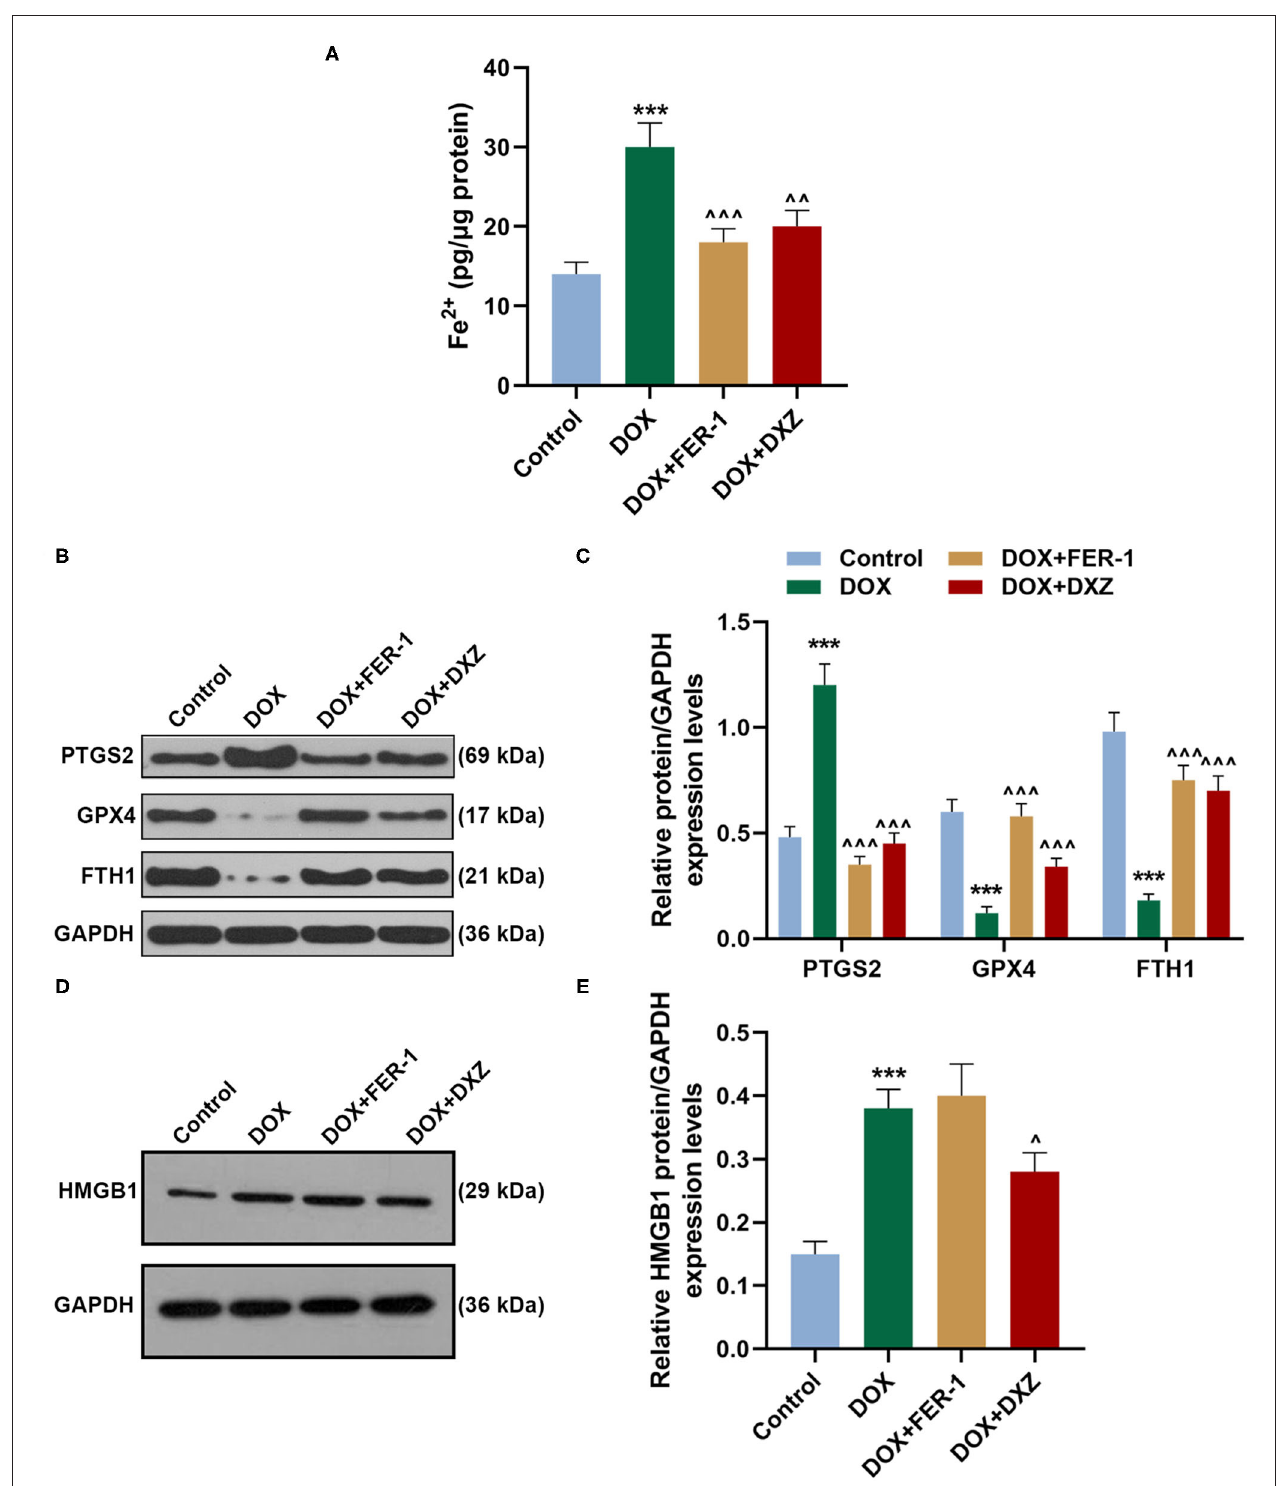
FIGURE 7 | Effects of HMGB1 and DXZ on DOX-induced ferroptosis of H9c2 rat cardiomyocytes. (A) The Fe 2 + content of H9c2 cells after drug treatment was detected by assay kits. (B–E) The relative protein expression levels of HMGB1, PTGS2, GPX4, and FTH1 were determined by Western blot. GAPDH served as a reference gene. *** P < 0.001 vs. control. ∧ P < 0.05, ∧∧ P < 0.01, ∧∧∧ P < 0.001 vs. DOX. All experiments were repeated three times. GPX4, glutathione peroxidase-4.